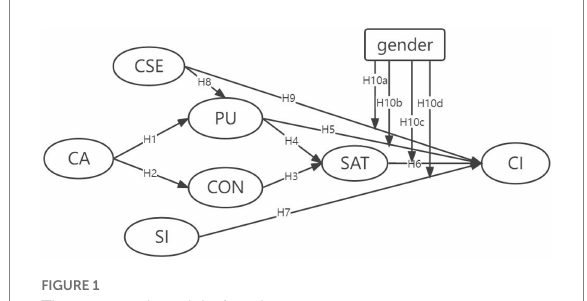
FIGURE 1 The proposed model of